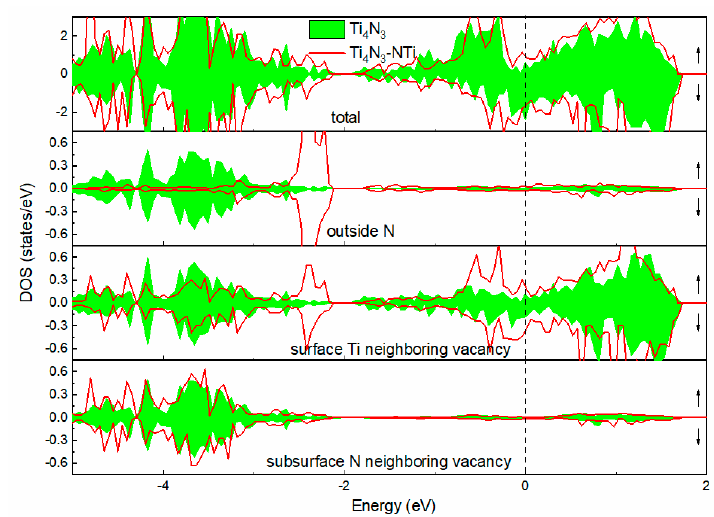
Figure 6. TDOS and PDOS of the Frenkel-type defected Ti 4 N 3 nanosheet. ↑ and ↓ indicate the spin-up and spin-down orbitals, respectively. The Fermi level (dashed vertical line) is set to zero. The TDOS is transited to a primitive cell.